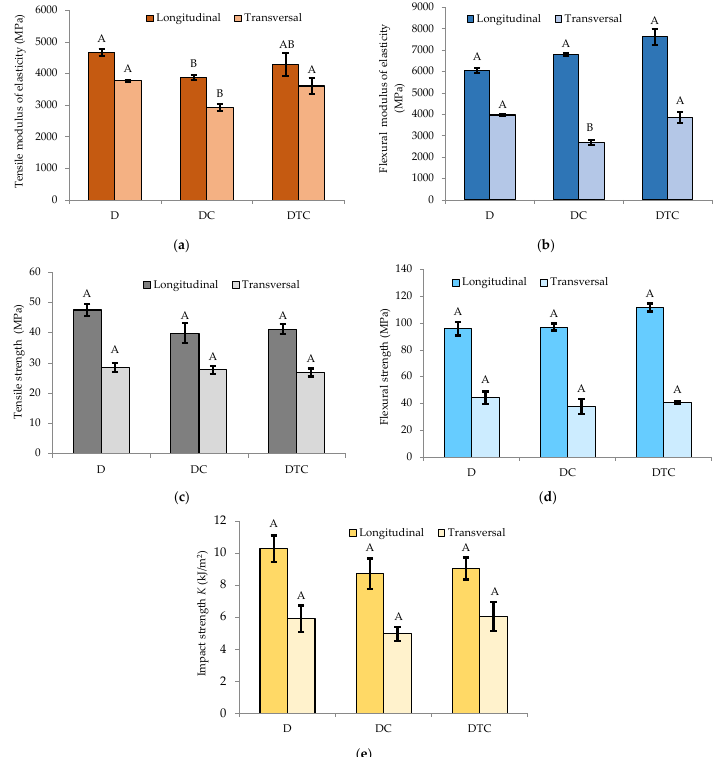
Figure 9. Comparison of the mechanical properties for the tested composite materials (variables with the same letter mean that the difference is not statistically significant): ( a ) tensile modulus of elasticity; ( b ) flexural modulus of elasticity; ( c ) tensile strength; ( d ) flexural strength; ( e ) impact strength. For the longitudinal tested samples, the highest average values of tensile strength and tensile modulus of elasticity, respectively, were recorded for the three-layer struc- tures D (47.5 MPa and 4678.6 Mpa, respectively), followed by five-layer structures with treated Calotropis DTC (41.2 MPa and 4289 Mpa, respectively) and untreated DC (39.8 MPa and 3877 Mpa, respectively). The same trend was noticed for impact strength (10.3 MPa for D composite, 9.1 MPa for DTC and 8.7 MPa for DC). Instead, the flexural mod- ulus of elasticity and flexural strength values increased with the addition of Calotropis fibres, the highest ones being reached by DTC composites with treated Calotropis fibres (average values of 7623 MPa for flexural modulus of elasticity and 111.7 MPa for flexural strength). Average values recorded for DC/ D structures were as follows: 6802 MPa/ 6072.5 MPa for the flexural modulus of elasticity and 97.1 MPa/ 95.7 for the flexural strength. The mechanical strength values recorded for the three-layer laminate (D) tested on the longitudinal direction are higher (flexural strength was 1.5 times higher and the ten- sile strength was 1.2 times higher) than those recorded in another study [28] for panels manufactured with 50:50 as weight ratio of date-palm fibres to epoxy resin, using date-palm fibres from different parts of the plant. As regarding the flexural modulus of elasticity, with the better interfacial adhesion and dispersion of fibres and matrix, there are better flexural modulus results [29]. As found in the literature [28,30–32], alkali treatment applied to natural fibres improves the adhesion between the fibres and matrix, improving the mechanical performance of the resulted composite. The results obtained in